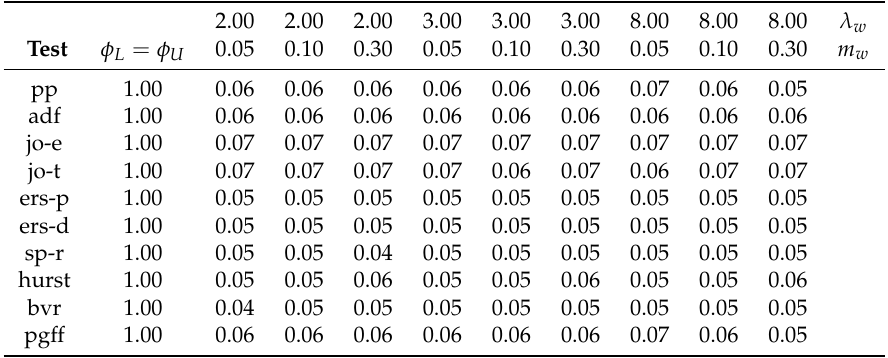
Table 12. Size of cointegration tests for Monte Carlo settings of Type V.